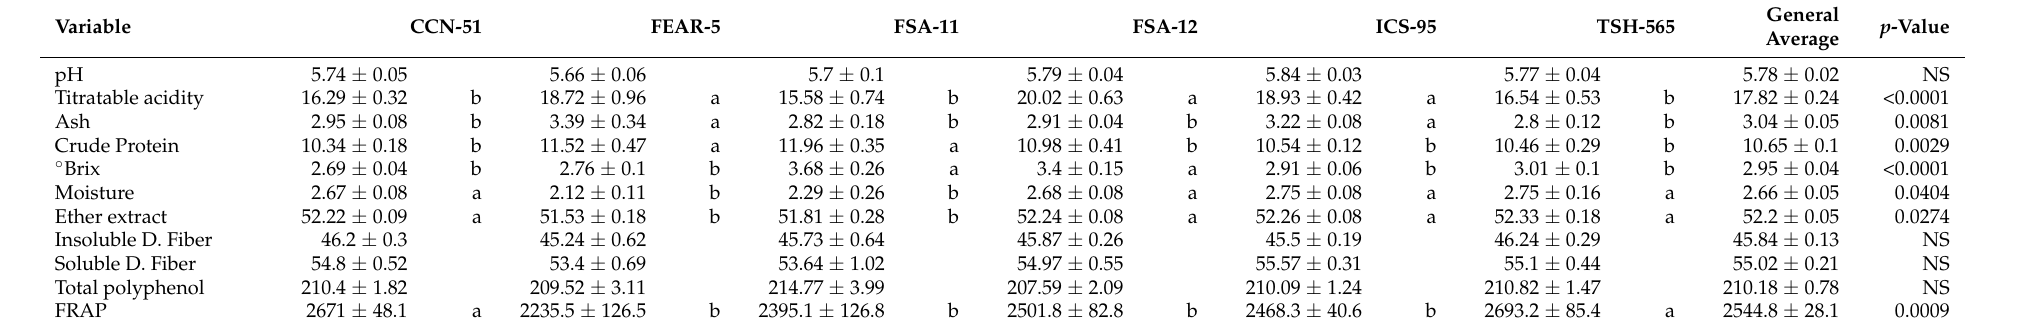
Table 1. Mean and standard error of physicochemical and functional properties of different cocoa clones from the department of Meta,